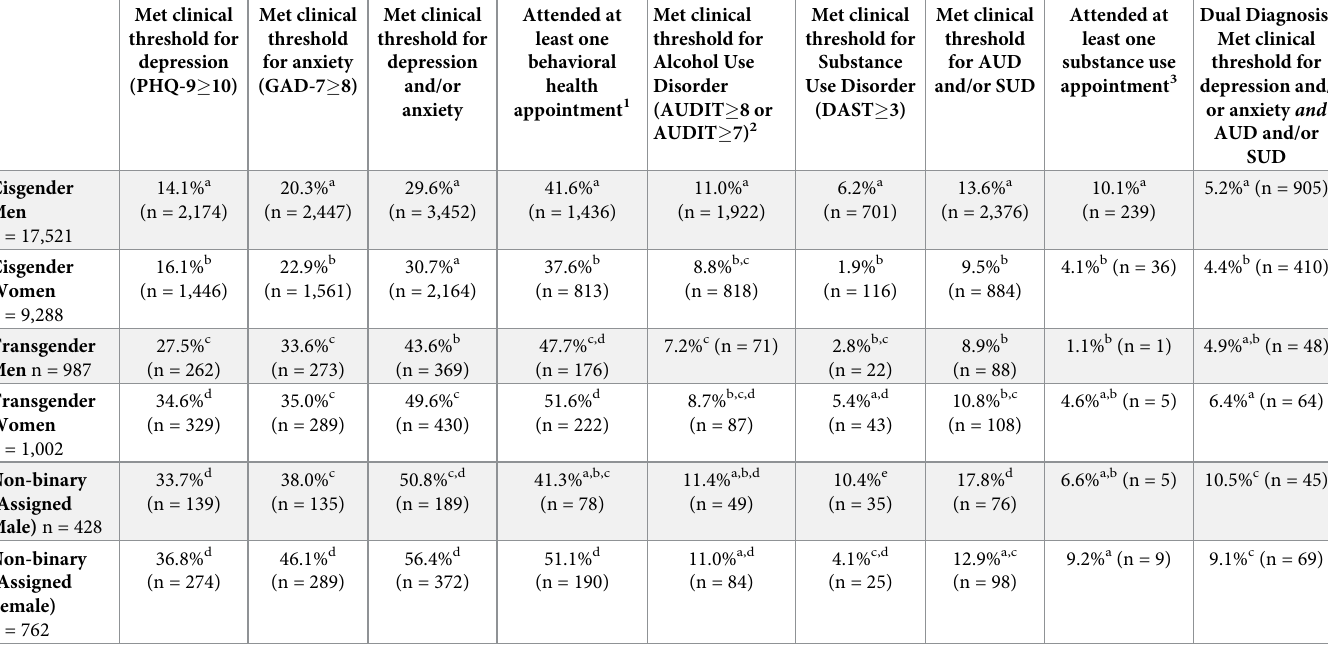
Table 3. Likelihood of meeting behavioral health and substance use clinical thresholds and appointment attendance by gender category. Met clinical threshold